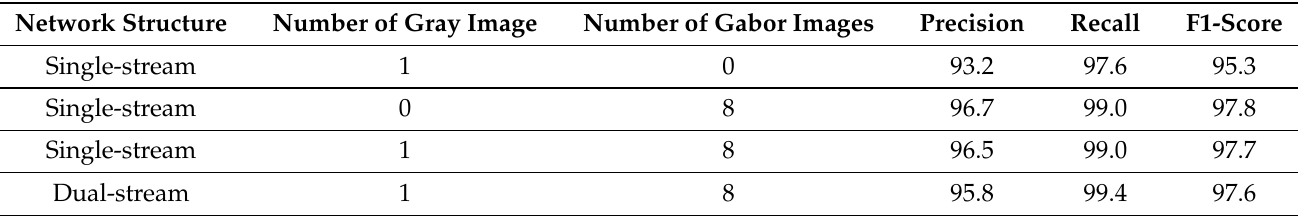
Table 3. Performance of proposed method on magnetic tile dataset.